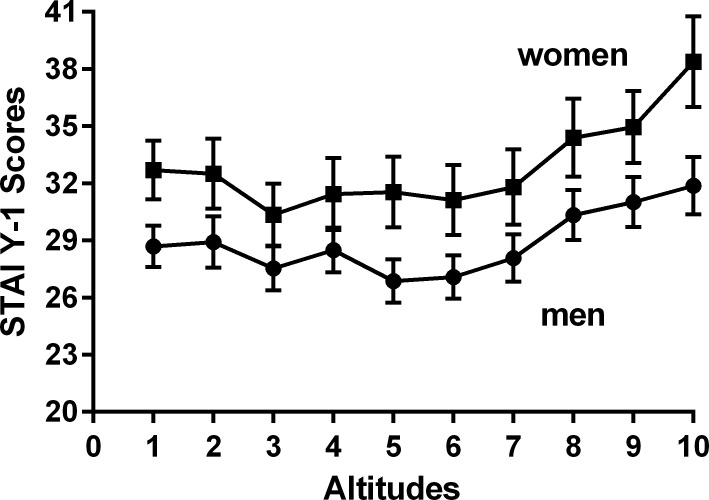
Comparative changes in STAI Y-1 Scores at each altitude in men versus women.